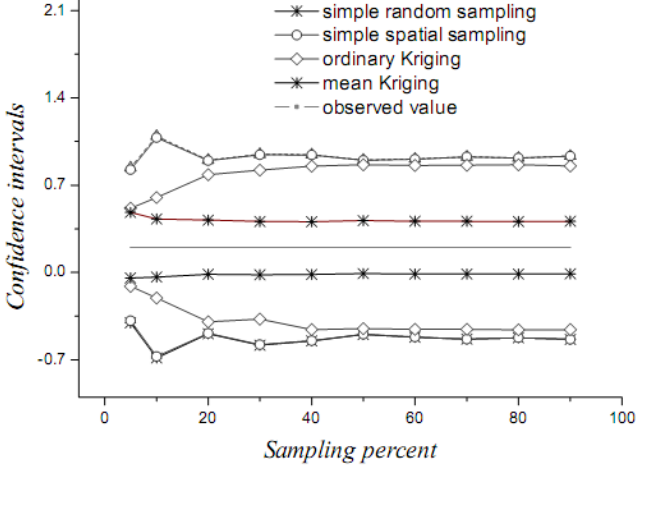
Figure 12. Confidence intervals of the estimated cultivated land proportion by various